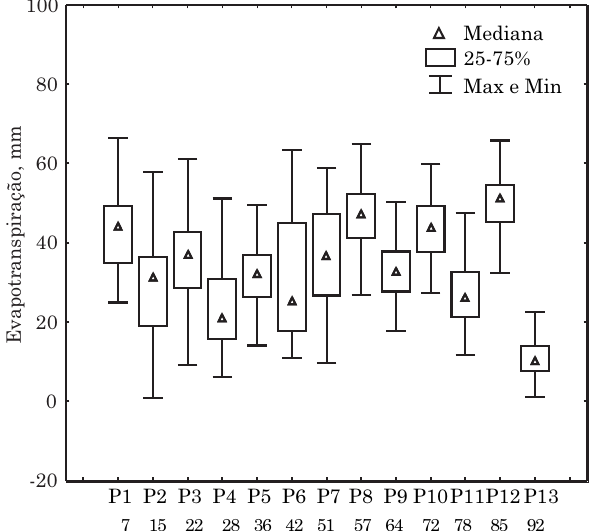
Figura 1. Evapotranspiração observada para os 13 períodos, em dias julianos, após a eliminação dos dados